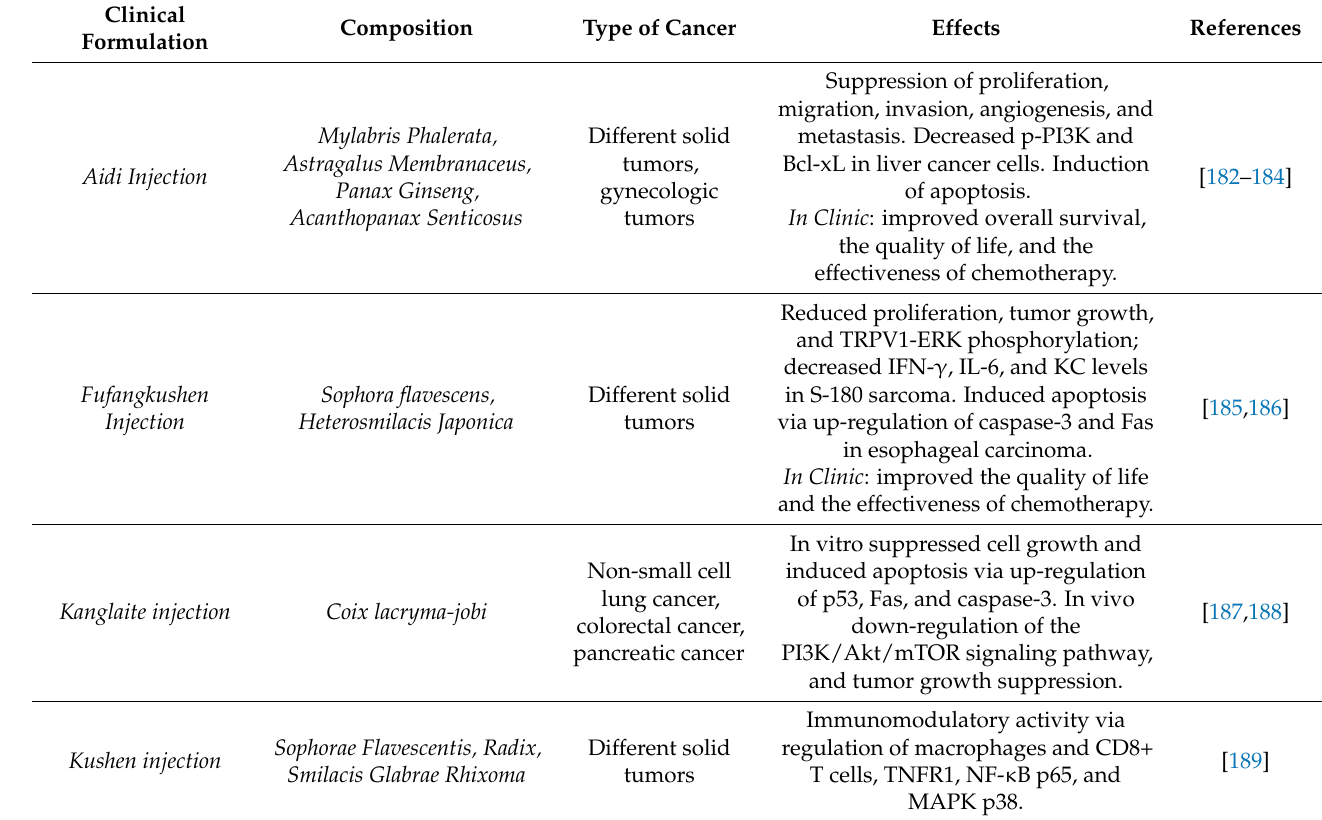
Table 3. Some frequently used traditional Chine’s formulations for a cancer